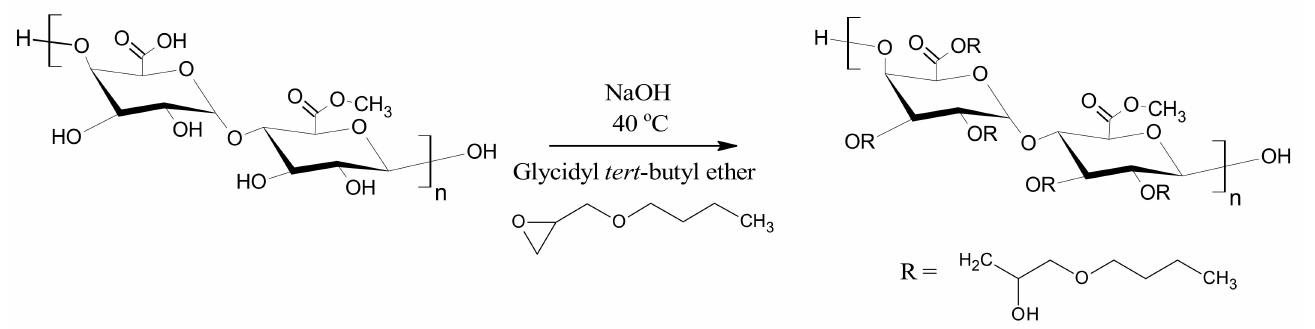
Figure 1. An illustration of the alkylated pectin